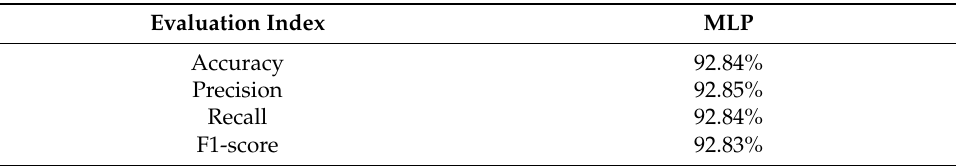
Table 12. Performance of Yolov4. Table 13. Performance of the